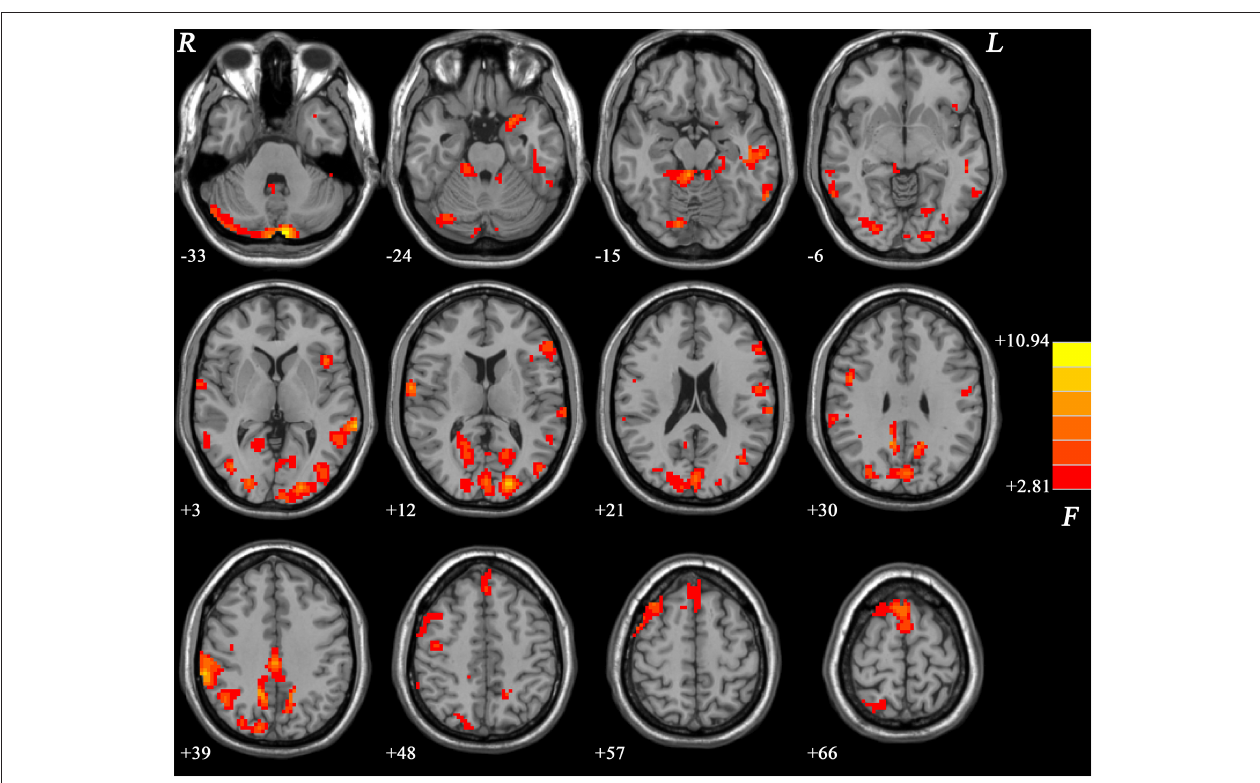
FIGURE 1 | Brain regions showing differences in ReHo values across the three groups. The color bar indicates F values from ANCOVA (age, years of education, and framewise displacement as covariates). ReHo, regional homogeneity; ANCOVA, analysis of covariance. The results were FDR (false discovery rate) corrected at p <